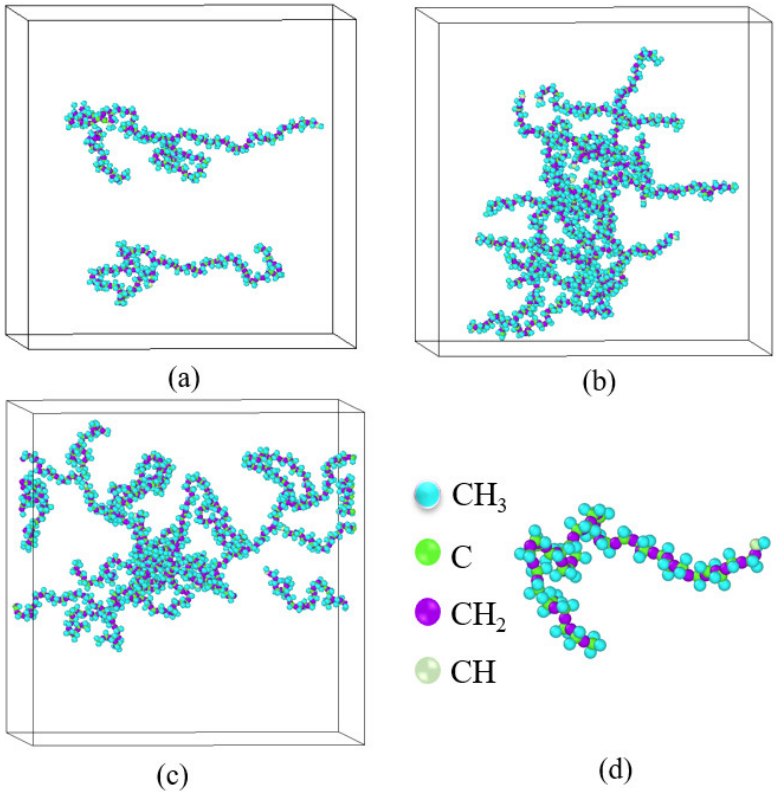
Figure 5. Conformational morphology of polymer molecules in ( a ) ns36np5, ( b ) ns36np15 and ( c ) ns60np9 solutions; ( d ) pseudoatomic groups in a single polymer molecule.